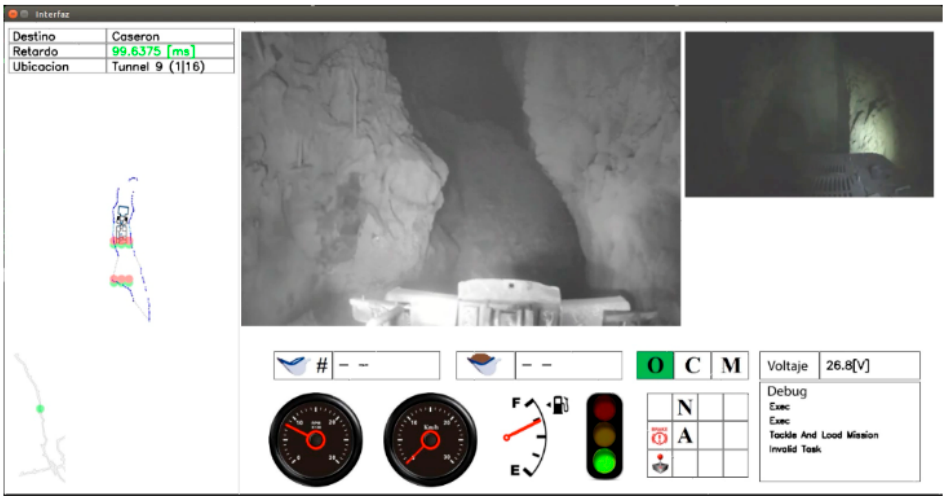
Figure 14. Operator’s graphical interface of the navigation system.